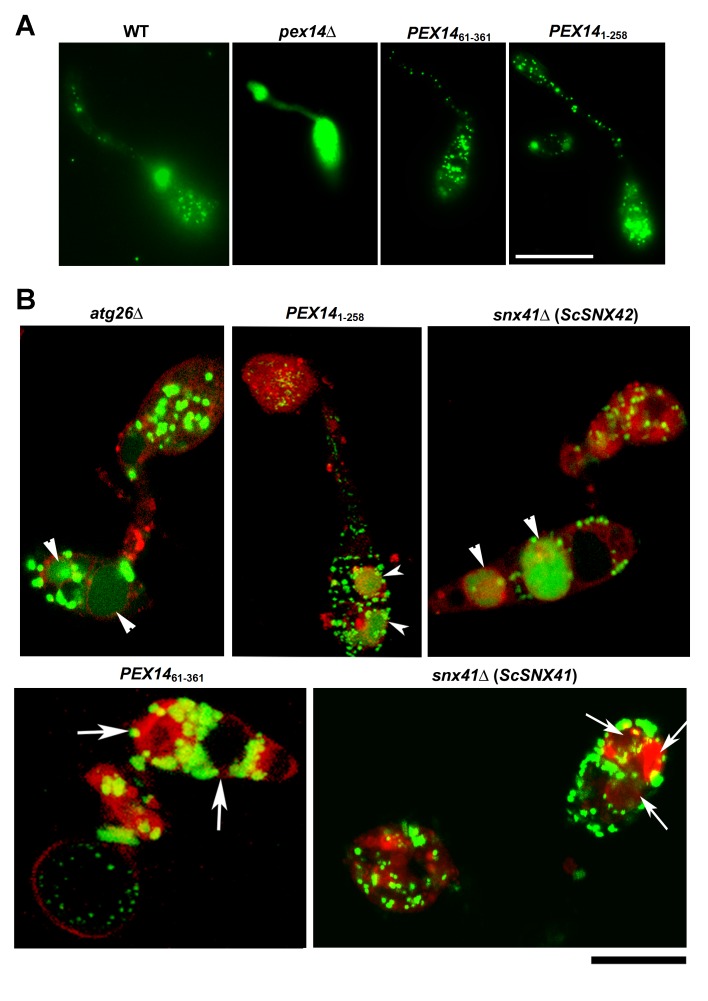
Characterization of pexophagy-deficient mutants in M. oryzae.(A) GFP-SRL mis-localizes to the cytoplasm in the pex14Δ mutant. Scale bar equals 10 micron. (B) Pexophagy is normal (restored) in M. oryzae
atg26Δ, PEX14
1-258, and snx41Δ (ScSNX42) strains (in GFP-SRL background). Vacuolar staining with Lysotracker Red DND99 was performed 5 min before confocal microscopy. Arrowheads denote vacuolar GFP-SRL. Conidia of PEX14
61-361 and snx41Δ with ScSNX41 (all in GFP-SRL background) co-stained with Lysotracker Red DND99 were analyzed by confocal microscopy. Arrows denote vacuolar compartments without GFP-SRL, indicative of a block in pexophagy. Bar = 10 μm.